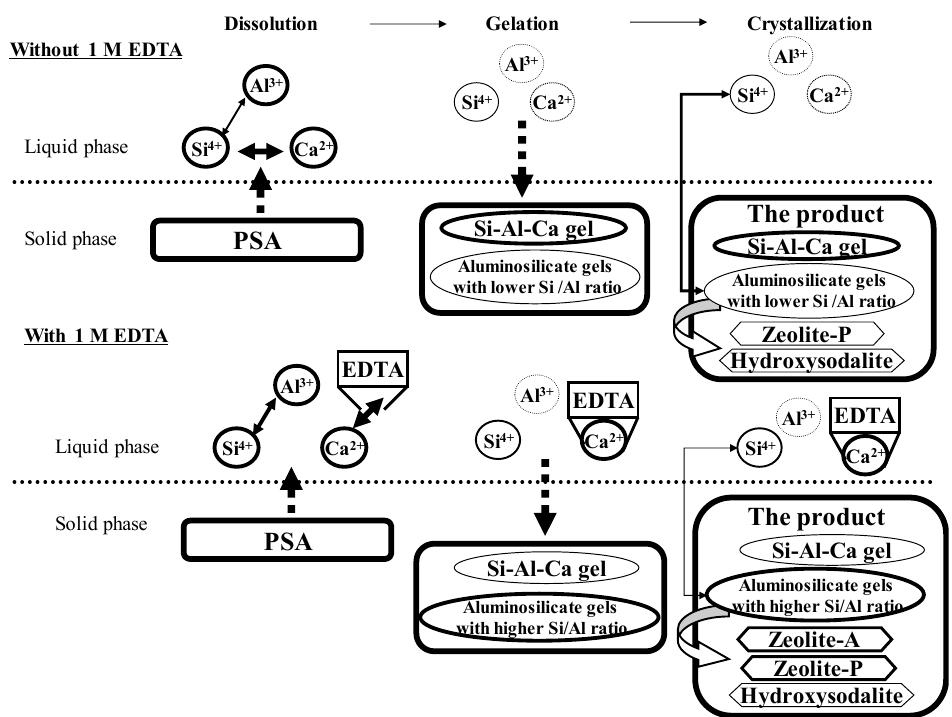
Figure 11. Proposed mechanisms for the zeolitic reaction with the addition of 1 M EDTA at 80 °C.